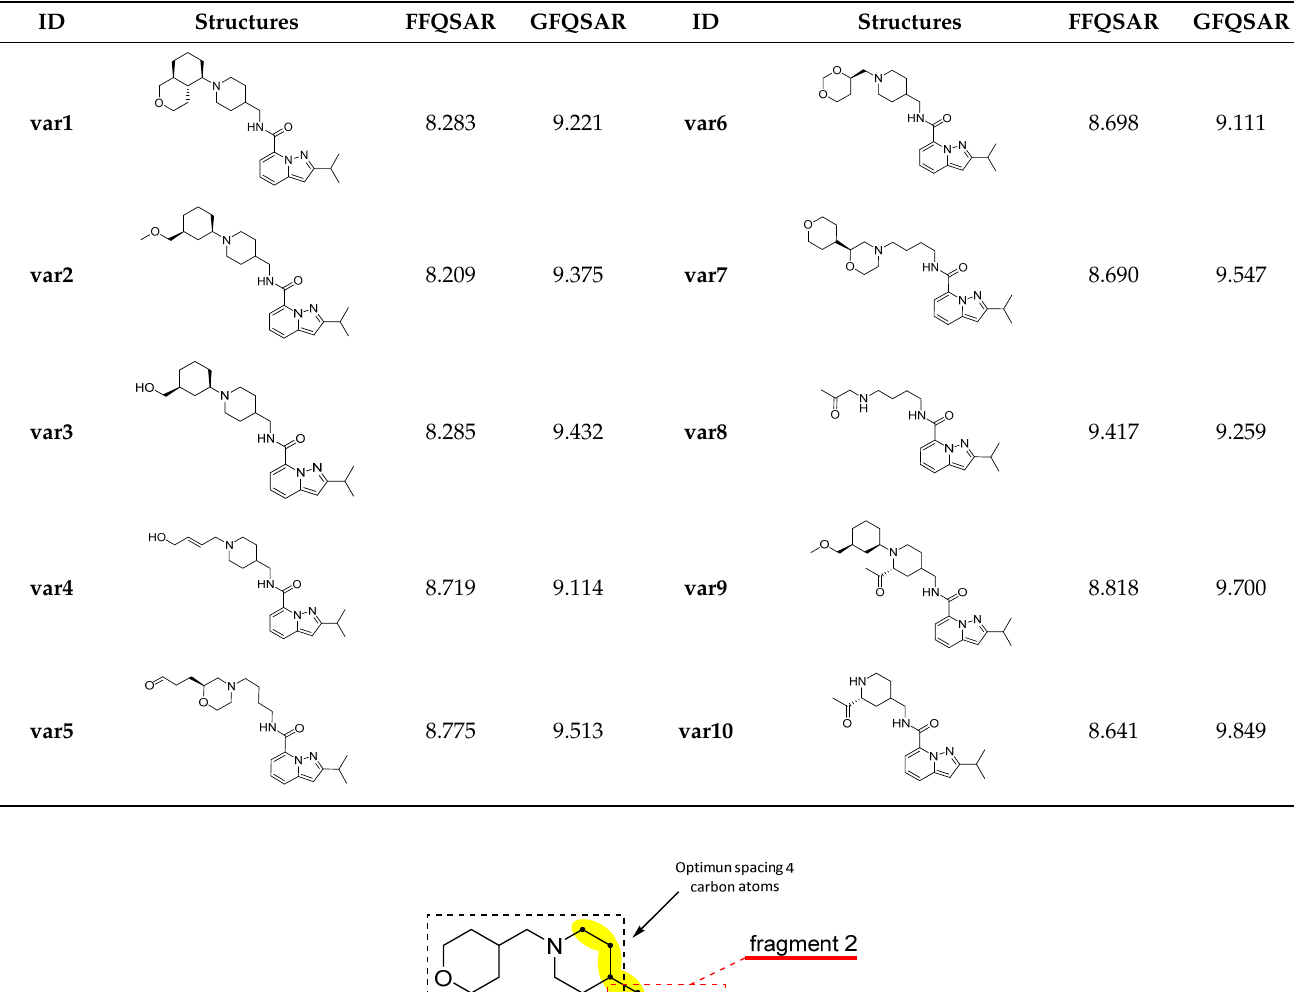
Table 4. The proposed structures of new derivates and their predicted pEC 50 values using the FFQSAR and GFQSAR models.